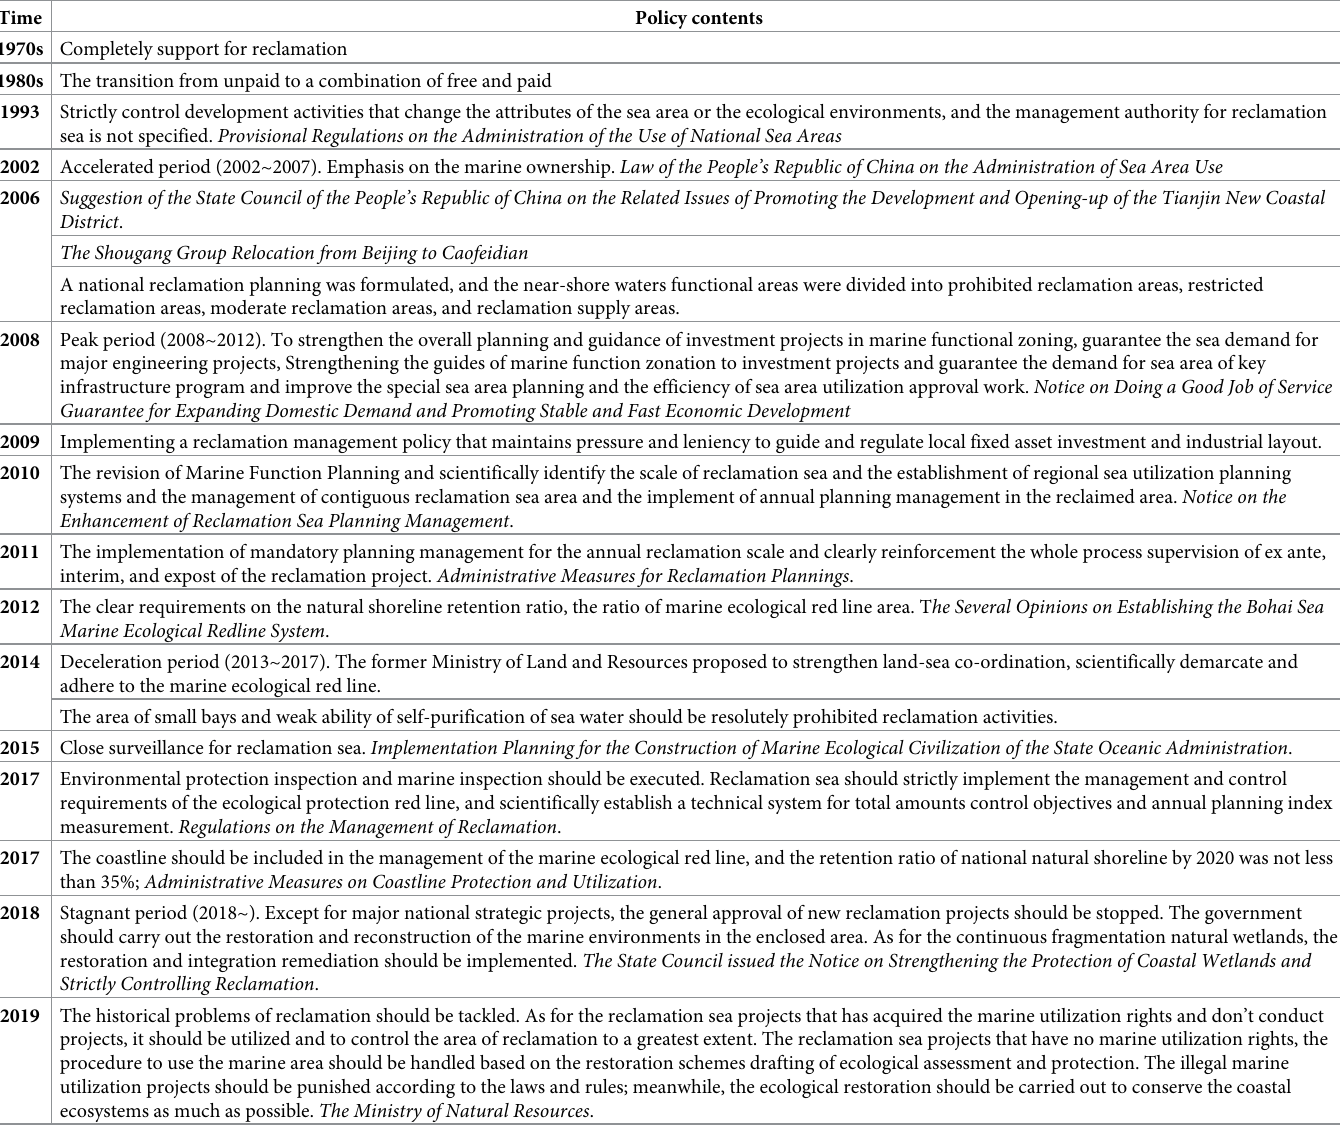
Table 6. The policy changes of the CLR in China since